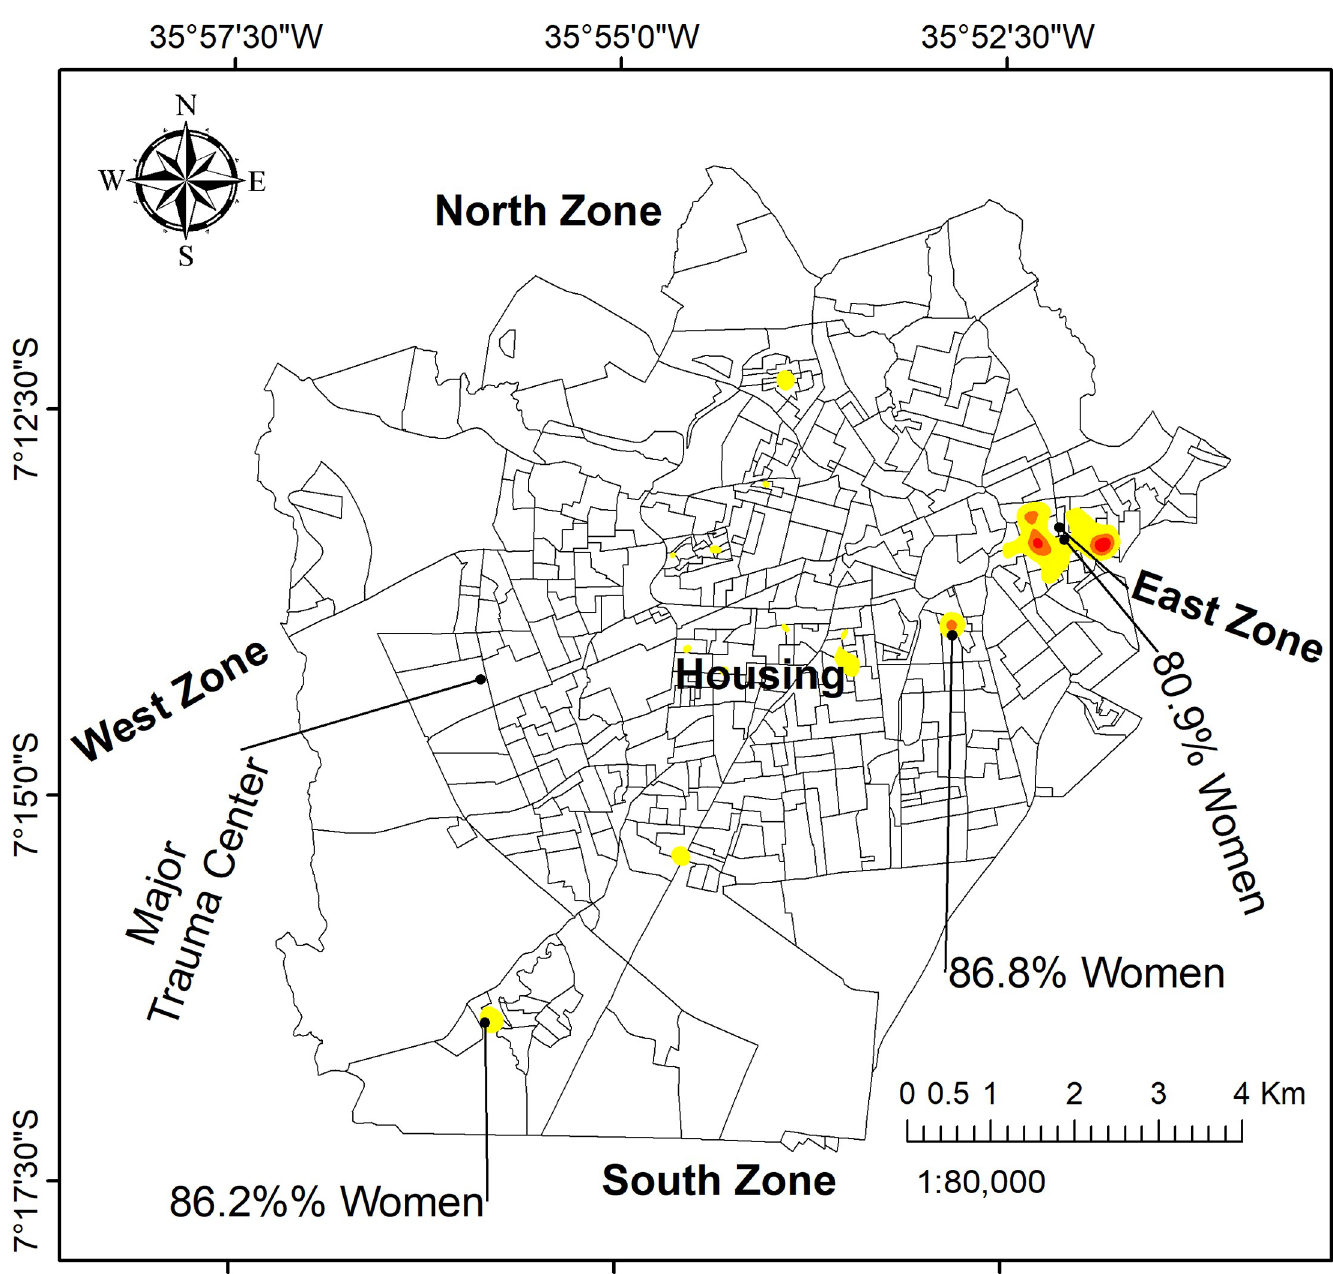
Fig 4. Density of domestic violence